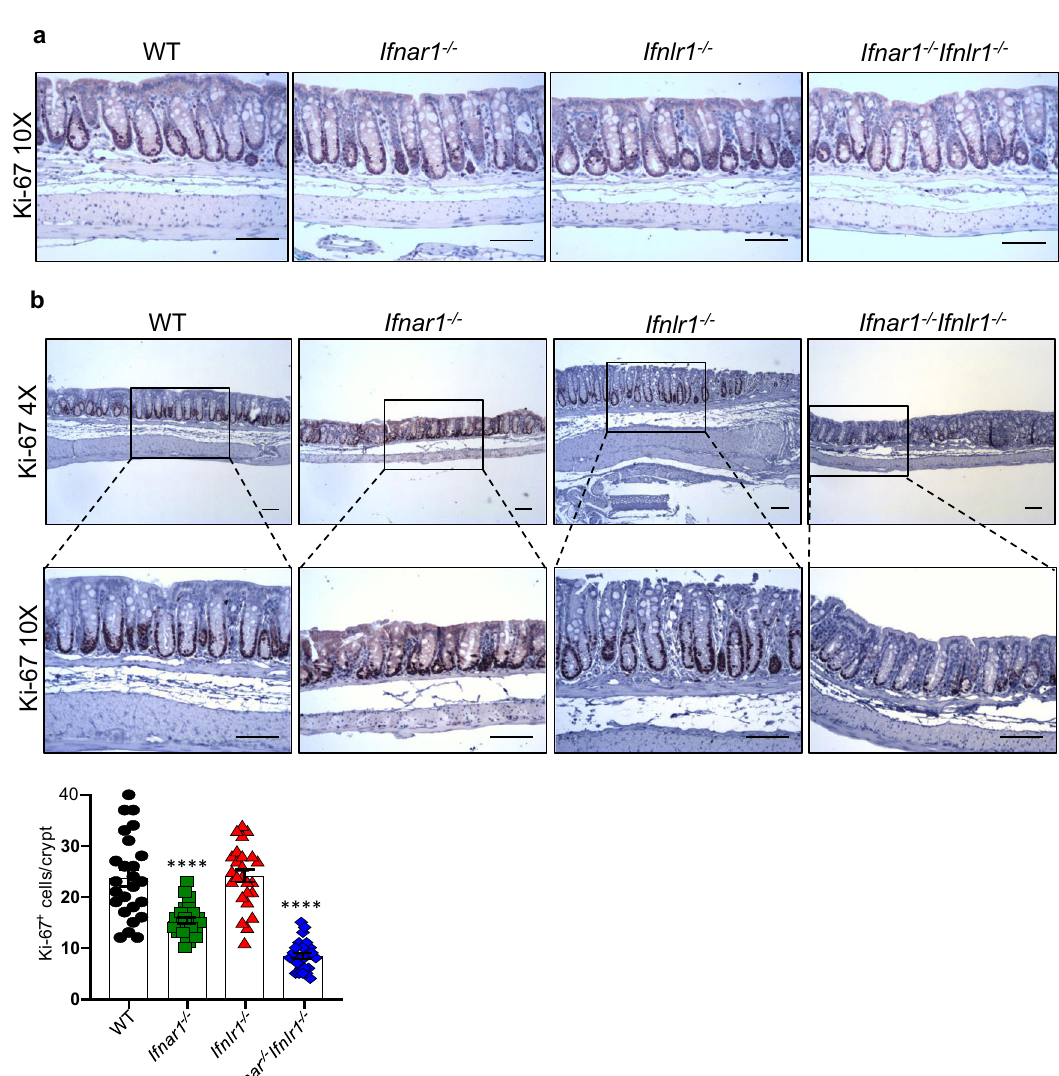
Fig. 4 Impaired proliferation of colon epithelium in Ifnar1 − / − Ifnlr1 − / − mice following DSS treatment. a 6 – 8-week-old naive WT, single or double IFNR- de fi cient mice receiving regular water were euthanized and proliferation of colon epithelial cells were evaluated by immunohistochemistry (IHC) staining for Ki-67 ( n = 5). b 6 – 8-week-old WT, single or double IFNR-de fi cient mice were exposed to 1.5% DSS in drinking water for 7 days, followed by regular drinking water for recovery. Mice were euthanized on day 8 and proliferation of colon epithelial cells was evaluated by IHC staining for Ki-67 ( n = 5). Representative colon images and quanti fi ed data are shown. Scale bars are 100 μ M. Data are representative of two independent experiments. Symbols represent the number of Ki-67 + cells per crypt ( fi ve crypt/slide/animal; n = 5). Quantitative data were analyzed using one-way ANOVA followed by Bonferroni ’ s multiple comparisons test and represent mean values with SEM. **** P ≤ 0.0001 and are for the indicated animal group compared with control group of WT